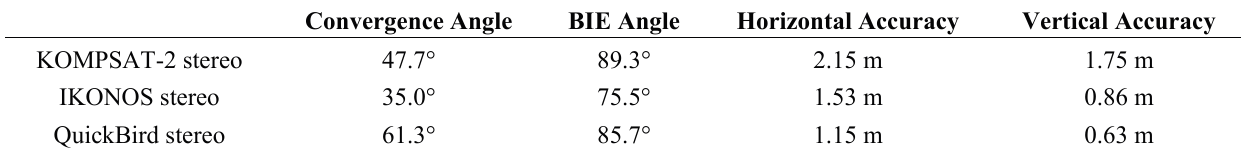
Table 2. Mapping accuracy of single-satellite stereo